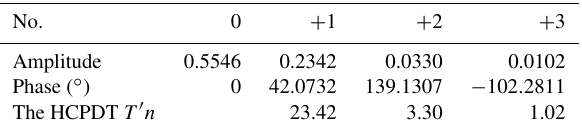
Table 4. The amplitude and phase of the prescribed orientation. Table 5. The identified MOBDT (10 groups are